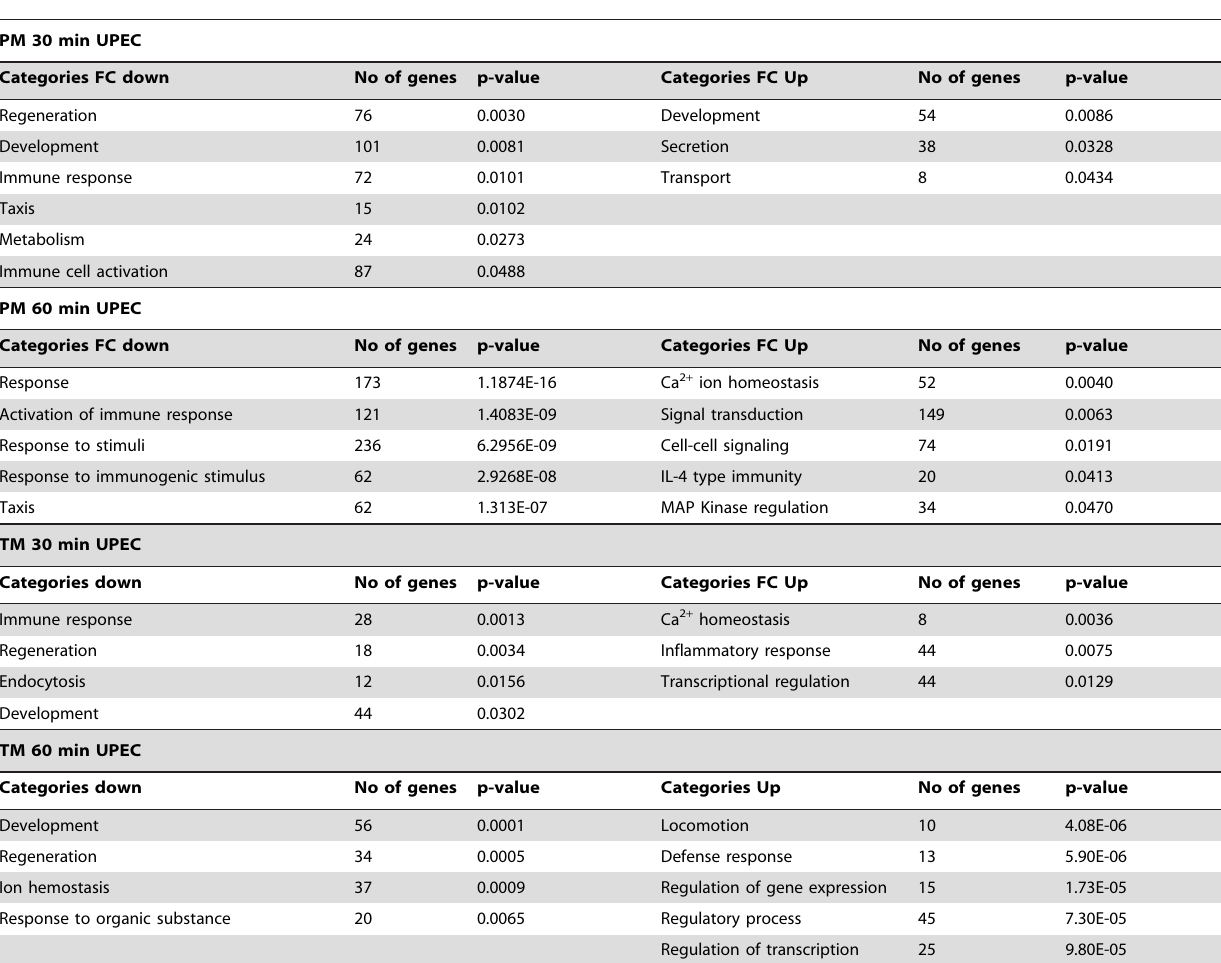
Table 3. Overrepresented biological categories of significantly regulated genes in PM and TM using